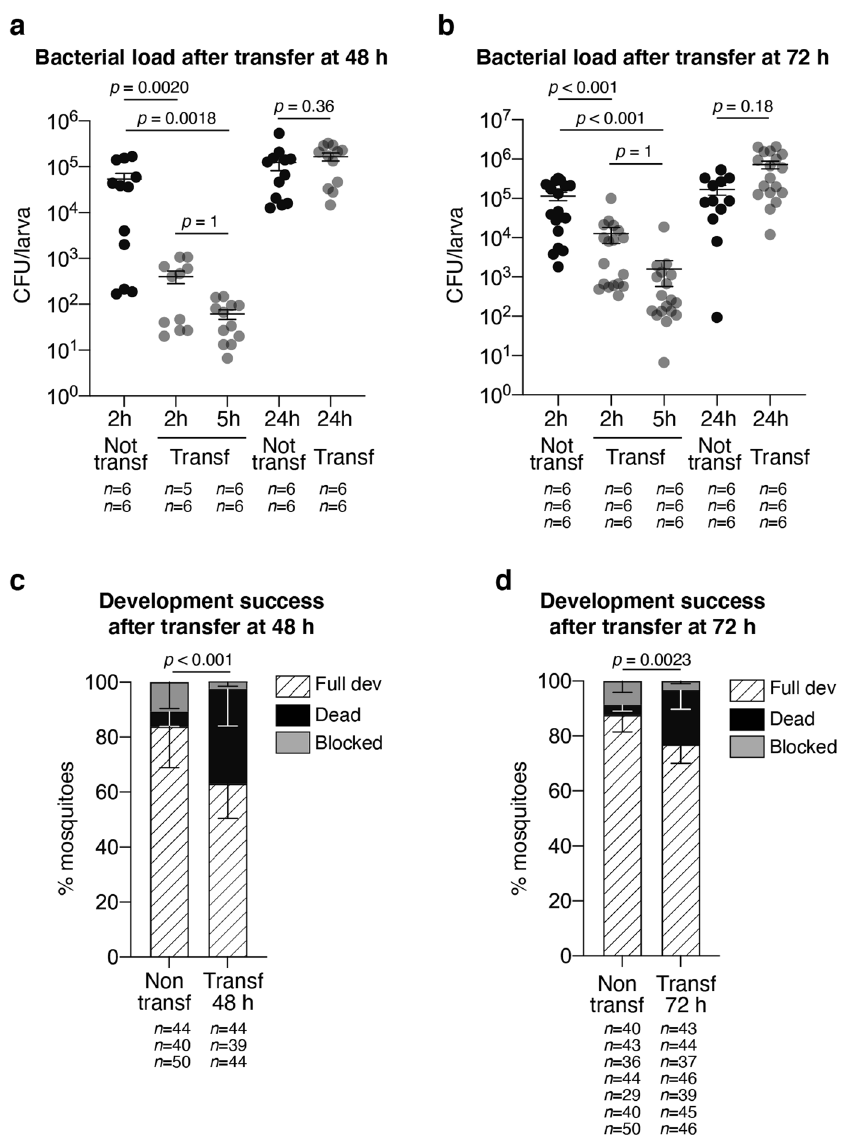
Fig. 4 Bacterial dynamics and developmental analysis of larvae reared in breeding site water and transferred to sterile rearing medium. a , b Colony forming units (CFU) count in larvae reared in water collected from Ae. aegypti breeding sites for 48 h ( a ) or 72 h ( b ) after 2, 5 and 24 h from transferring into sterile rearing water. Bacterial loads of non-transferred larvae are shown in black, while those of transferred larvae are shown in grey. c , d Development success of larvae continuously reared in breeding site water or transferred into sterile rearing water after 48 h ( c ) or 72 h ( d ) expressed as percentage of individuals reaching adulthood (striped bars), dying (black bars) and with stalled development (grey bars). In ( a – d ), data show mean ± SEM of two ( a ), three ( b , c ) or seven ( d ) independent replicates. The exact number of individuals analysed per condition and replicate is indicated in each panel. Statistical signi fi cance was determined with generalised linear mixed models and least square means with Bonferroni correction. Exact p values are indicated in the fi gure. See Table S1 for detailed statistical information. Source Data are provided as a Source Data fi